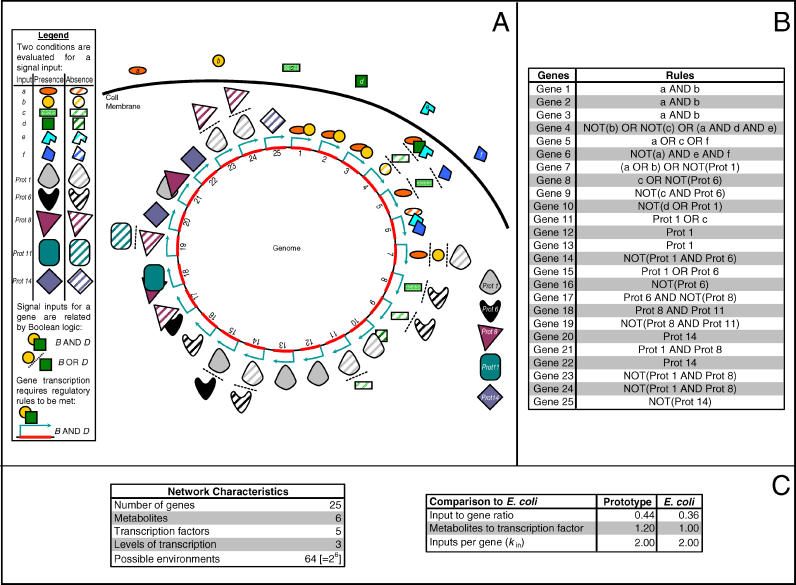
A Prototypic TRN(A) A prototypic TRN consisting of 25 genes, six extracellular metabolites, and five transcription factors, is shown. This prototype was constructed on the basis of the general characteristics of the E. coli TRN.(B) The Boolean regulatory rules that correspond to the transcription of the 25 genes within the prototypic TRN are listed.(C) Relevant characteristics of the prototypic TRS, including comparisons to the TRS of E. coli, are presented. This prototypic TRS gives rise to 64 [= 26, where there are six inputs] possible environments, and these may be evaluated using the 64 different matrices that are generated by combining the TRS R matrix with each of the 64 different environment matrices (E).